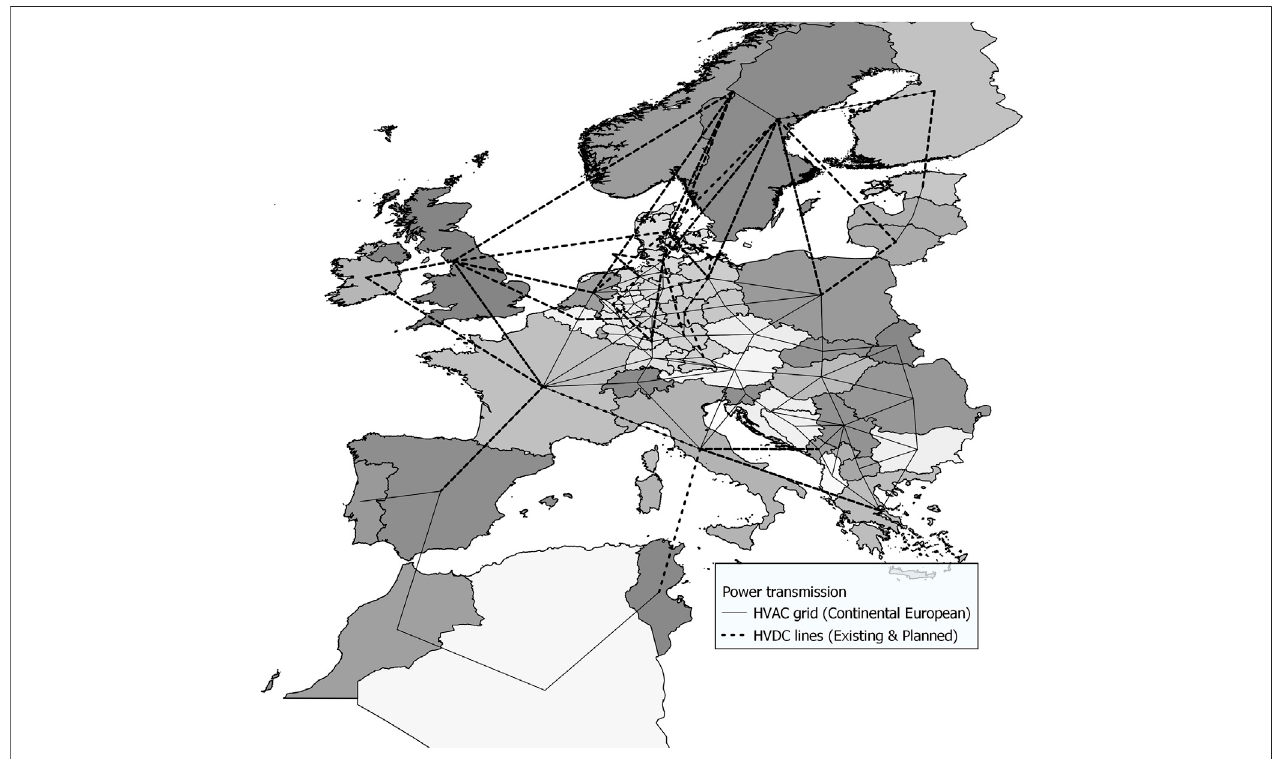
FIGURE 2 | Geographical scope, abstraction of transmission grid, and spatial resolution within